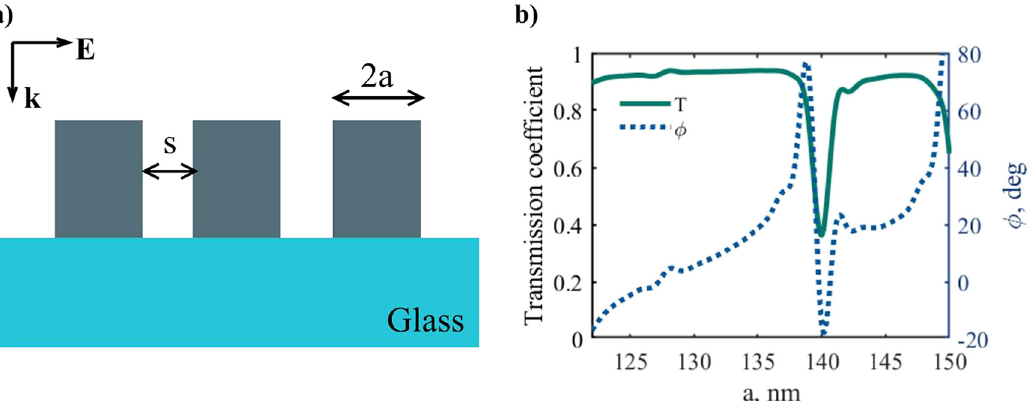
Figure 6: (a) Illumination scheme and geometry of the HA metasurface deposited on a semi-infinite glass substrate. (b) A lookup table of the hybridanapolemeta-atomwhenplacedontopofaglasssubstrate( n sub =1.5),for s =300nm.Theplotdisplaystransmission(left y -axis),and transmitted phase (right y -axis) as a function of the nanorod radius a .